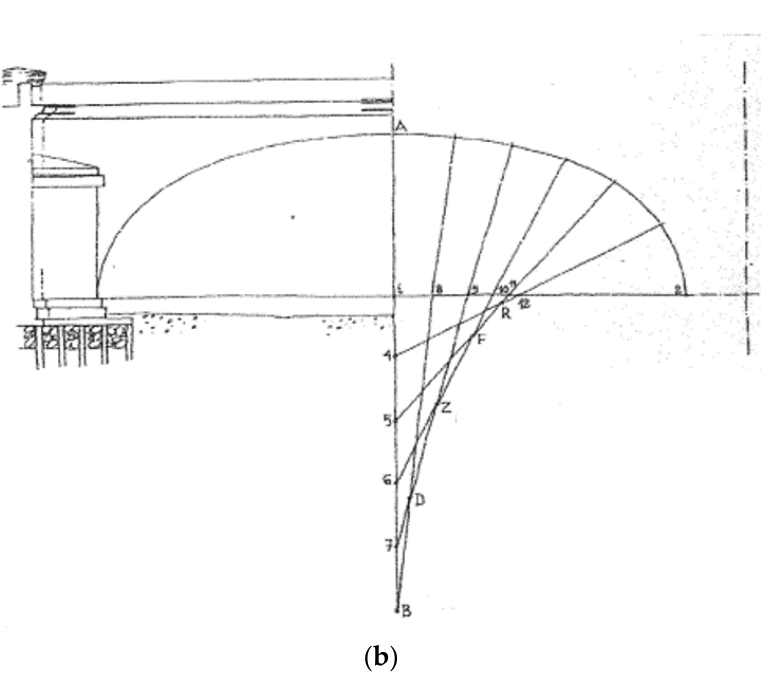
Figure 11. Vittorio Emanuele I Bridge, Turin (Italy): Overview ( a ); Sketch of the polycentric arch ( b ).